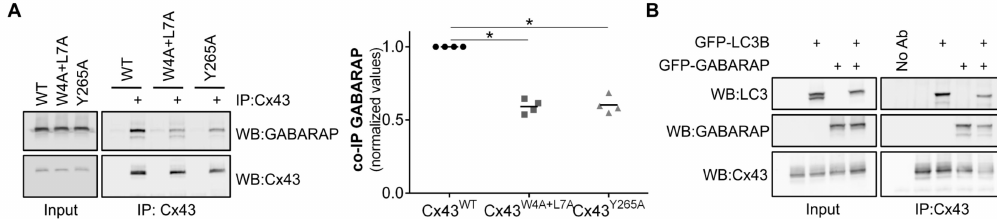
Figure 6. Mutation of the LIR motif of Cx43 impairs its binding to GABARAP and confers resistance to nutrient deprivation induced autophagy. ( A ) HEK293A cells were co-transfected with GFP-GABARAP and either wild type (WT) or mutant Cx43 (W4A + L7A, Y286A). Cell lysates were then subjected to immunoprecipitation with goat polyclonal antibodies against Cx43, and the precipitates were analysed using Western blot using rabbit polyclonal antibodies against Cx43 and GABARAP. The level of co-immunoprecipitated GABARAP with each connexin was quantified, normalized to the immunoprecipitated connexin and plotted in a graph. * p < 0.05, ns: non-significant using the Mann-Whitney test. ( B ) HEK293A cells were co-transfected with Cx43 and either GFP-LC3B, GFP-GABARAP or both. Cell lysates were then subjected to immunoprecipitation with goat polyclonal antibodies against Cx43, and the precipitates were analysed using Western blot using rabbit polyclonal antibodies against Cx43, LC3B and